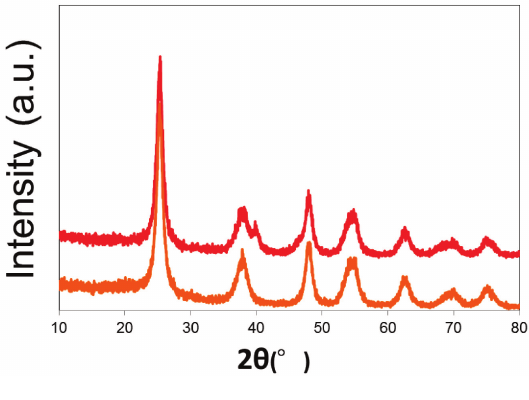
(red line) and TiO 2